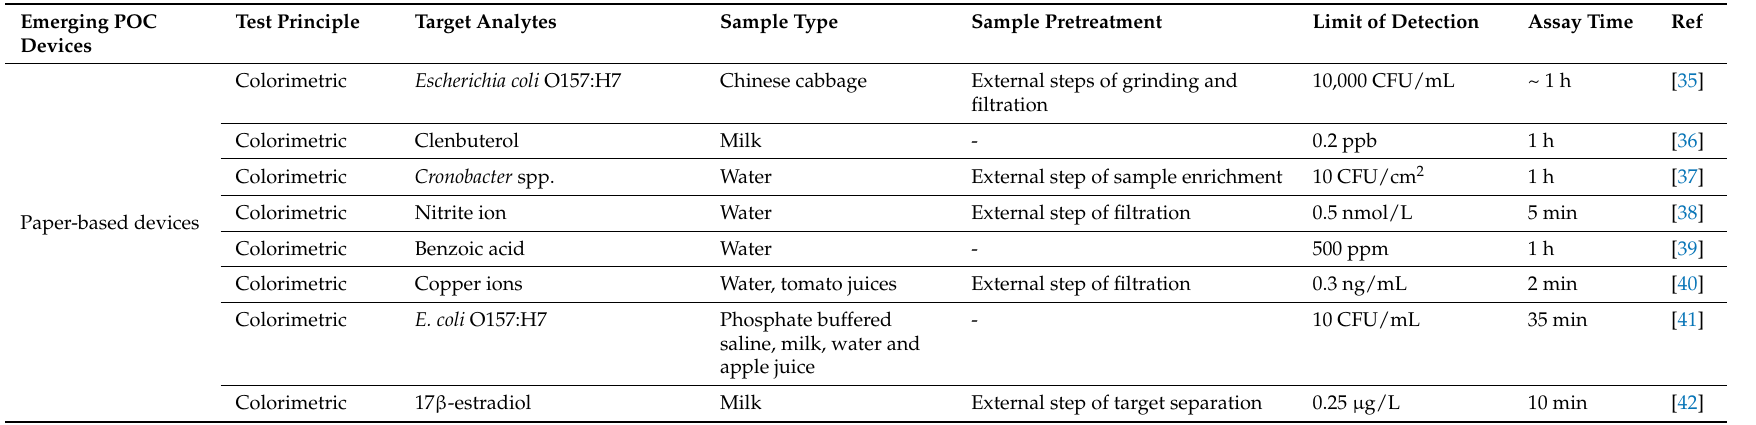
Table 2. Emerging point-of-care (POC) devices for food safety